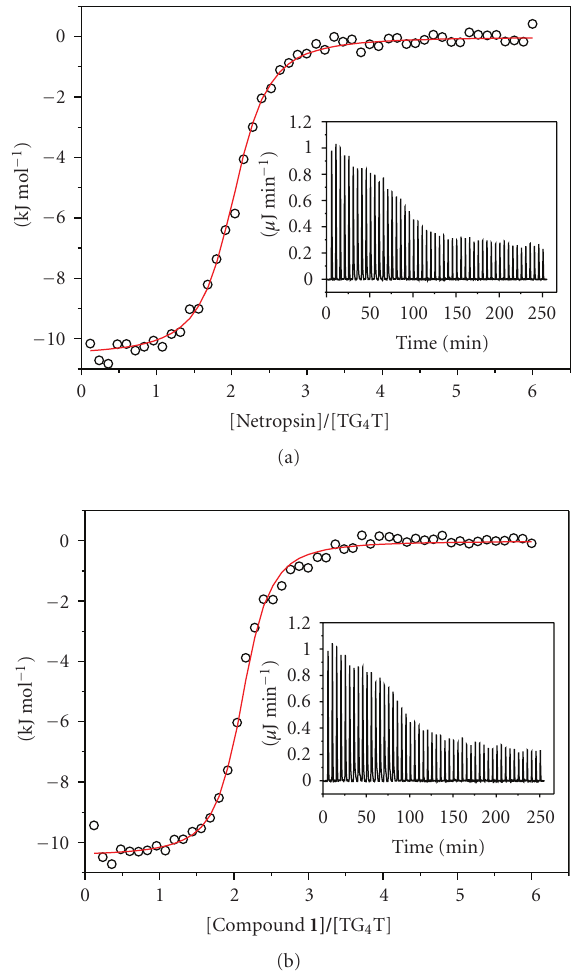
Figure 4: Raw ITC data (insets) and binding isotherms for titration of [d(TGGGGT)] 4 with netropsin (a) and with compound 1